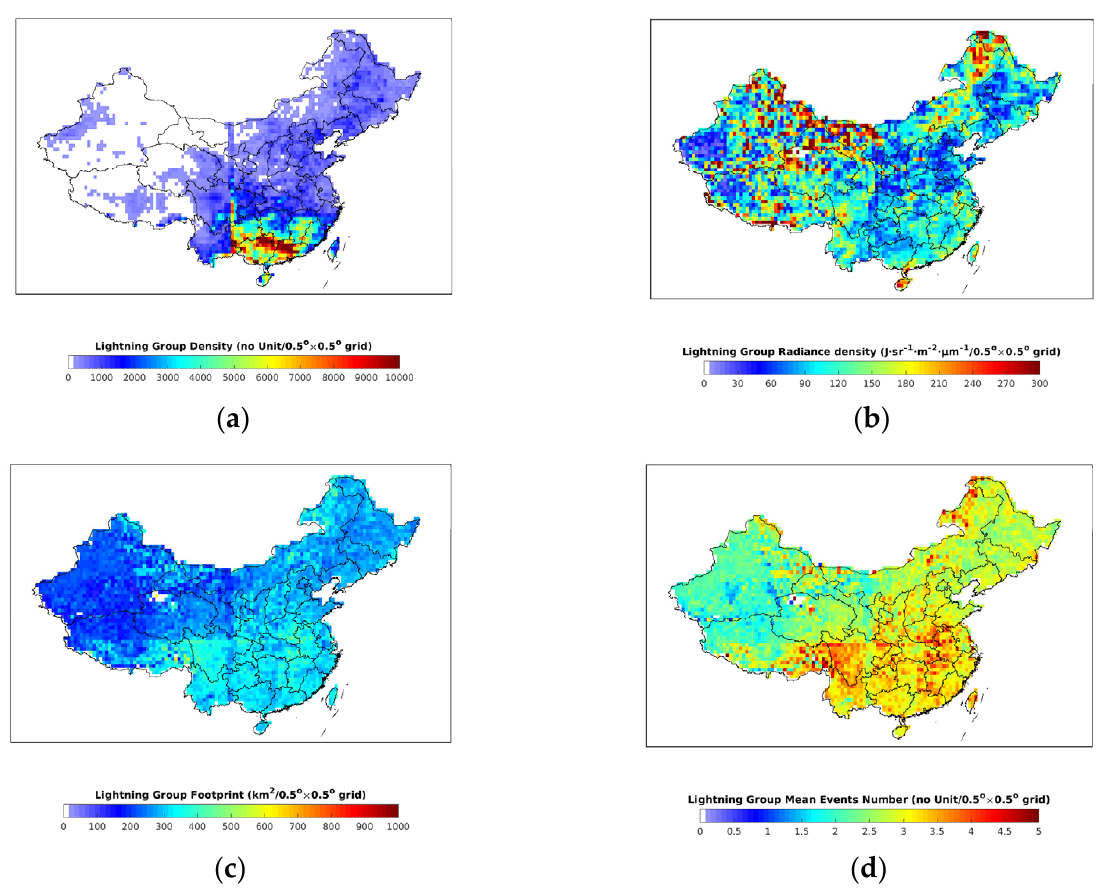
Figure 7. Spatial distribution features of LMI Group. ( a ) LMI Group density, ( b ) Group Radiance, ( c ) Footprint, and ( d ) Event number.